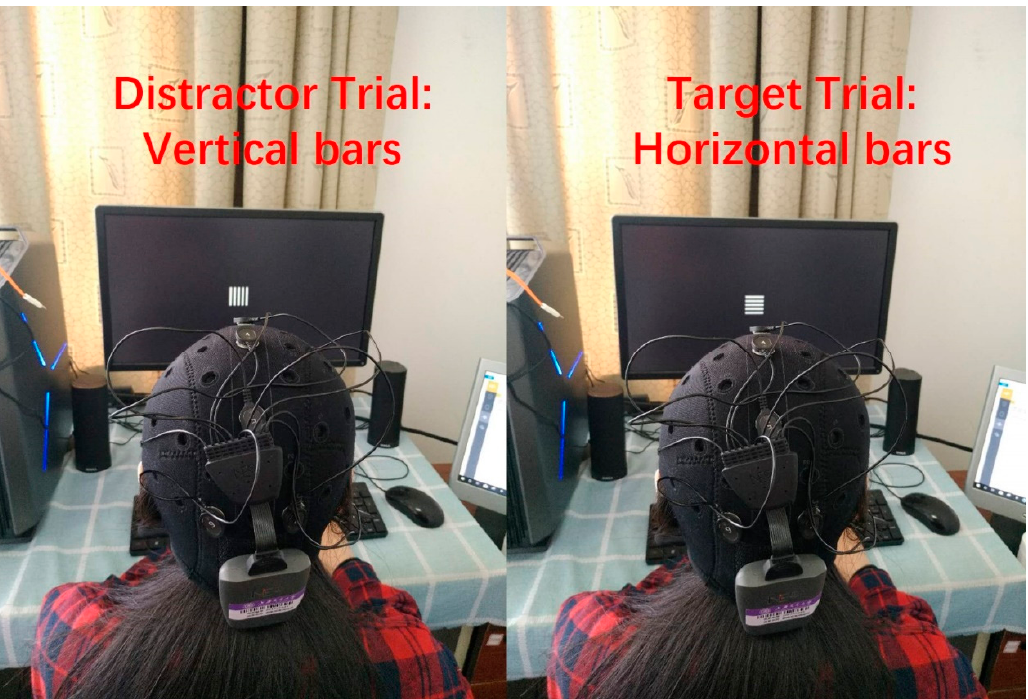
Supplementary Figures for Virtual ART Figure A2. Screenshots from ST-ART showing ( a ) the task 1, ( b ) the reward following task 1 (clear sky), ( c ) the light snow during task 2, and ( d ) the reward following task 3 (aurora).